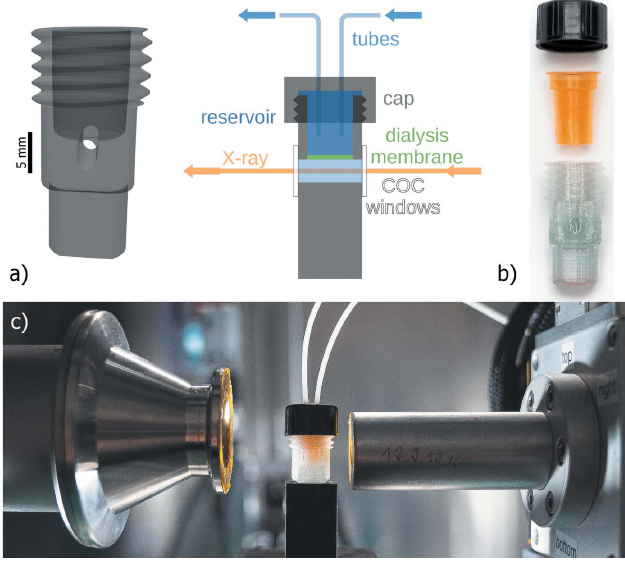
Figure 1 Chamber design principle and implementation. ( a ) Schematic drawing of the COC chamber. ( b ) Sample corpus is 3D-printed out of COC to enclose the coloured dialysis tube. Two COC X-ray windows allow for measurement of both condensed and diluted phases. ( c ) Sample setup for in situ measurements and dialysis using syringe pump